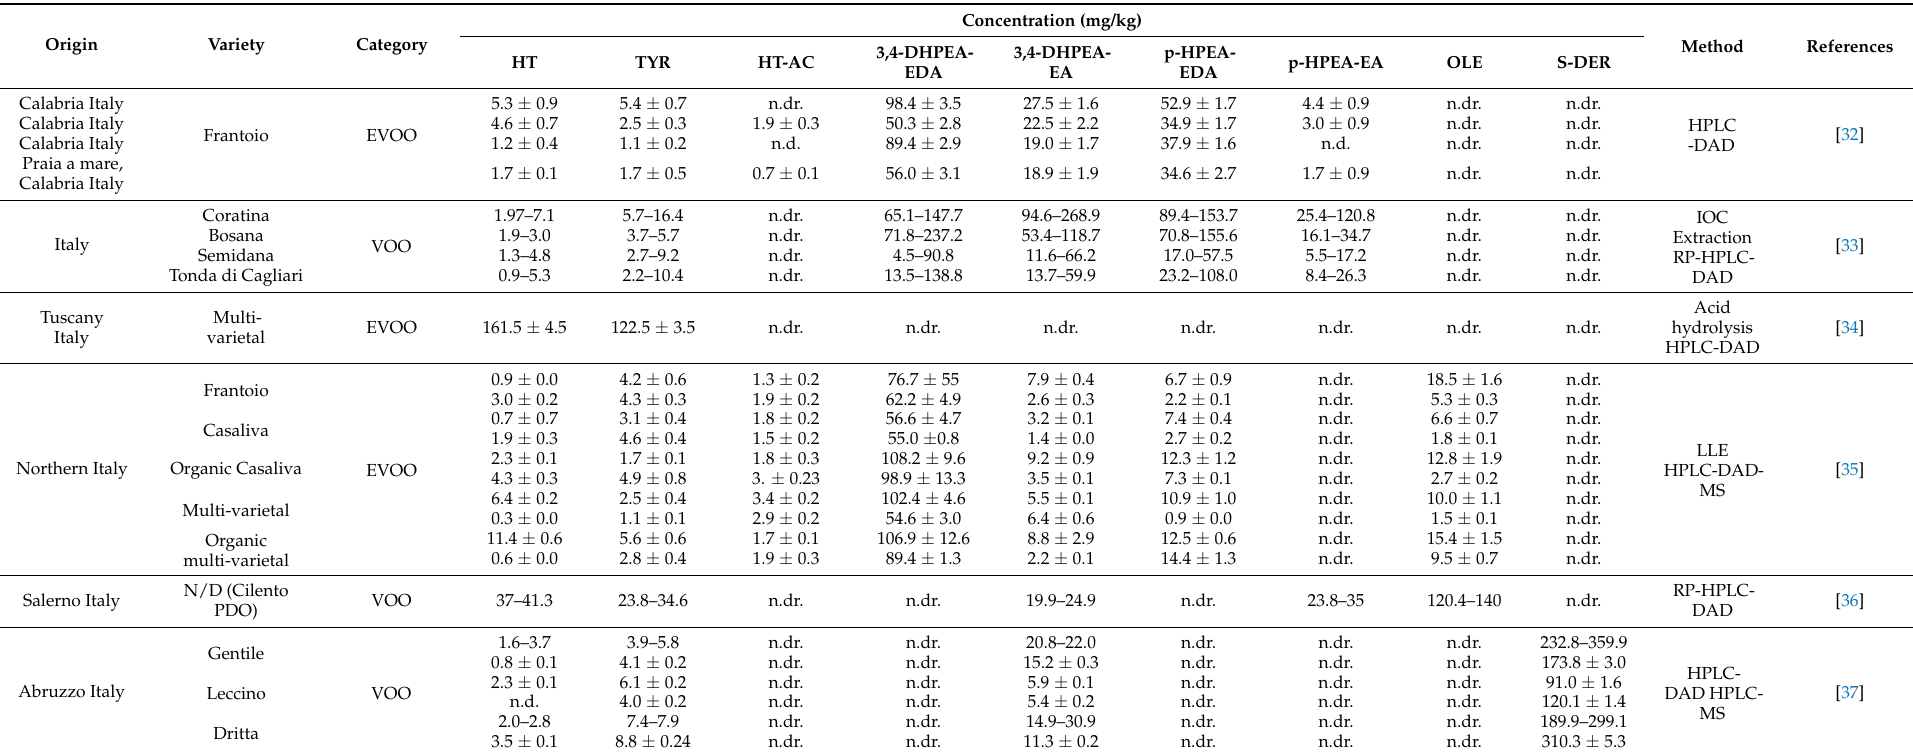
Table 2. Hydroxytyrosol (HT), tyrosol (TYR), hydroxytyrosol acetate (HT-AC), oleuropein-aglycone di-aldehyde (3,4-DHPEA-EDA), oleuropein-aglycone mono- aldehyde (3,4-DHPEA-EA), ligstroside-aglycone di-aldehyde (p-DHPEA-EDA), oleuropein (OLE) and secoiridoids derivative (S-DER) concentration in olive oil samples according to origin, variety, category, processing and analytical